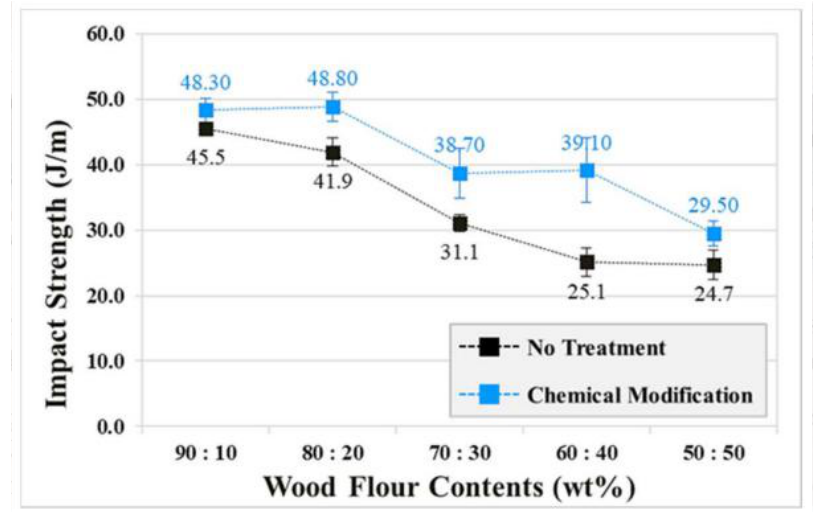
Figure 9. Impact strengths of chemically modified and untreated wood-plastic composite injection-molded ASTM